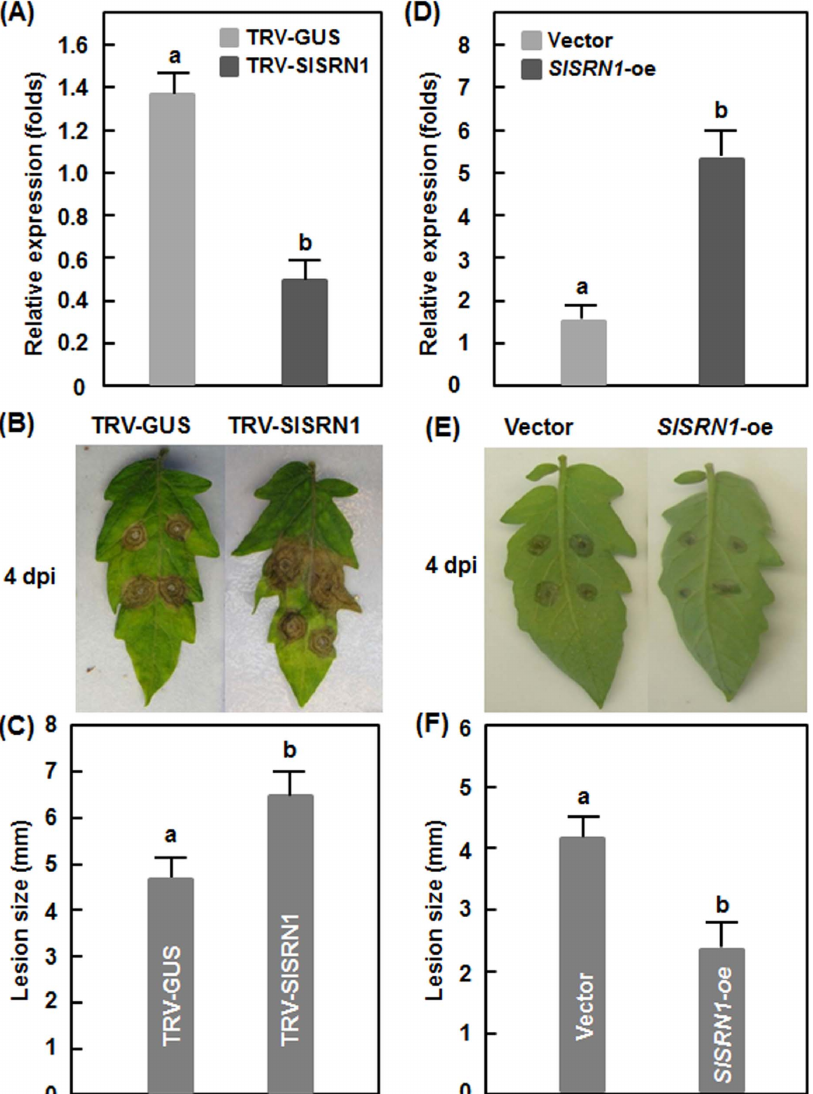
Figure 4. SlSRN1 positively regulates resistance response against B.cinerea . A–C. Silencing of SlSRN1 led to enhanced susceptibility to B. cinerea . A. Silencing efficiency in TRV-SlSRN1-infiltrated tomato plants. Two-week-old seedlings were infiltrated with agrobacteria carrying TRV-SlSRN1 or TRV-GUS and leaf samples were collected 4 weeks after VIGS treatment. The transcript of SlSRN1 was analysed by qRT-PCR. B and C. Disease phenotype and lesion size on detached leaves of TRV-SlSRN1 or TRV-GUS-infiltrated plants after inoculation with B. cinerea , respectively. D-E. Transient overexpression of SlSRN1 resulted in increased resistance to B. cinerea . D. Expression of SlSRN1 in pFGC-SlSRN1- or pFGC-eGFP-infiltrated plants. Leaves of 3-week-old seedlings were infiltrated with agrobacteria carrying pFGC-SlSRN1- or pFGC-eGFP vector and leaf samples were collected 3 days after infiltration. E and F. Disease phenotype and lesion size on detached leaves of pFGC-SlSRN1- or pFGC-eGFP-infiltrated plants after inoculation with B. cinerea , respectively. Data presented are the means 6 SD from three independent experiments and different letters above the columns indicate significant differences at p , 0.05 level.